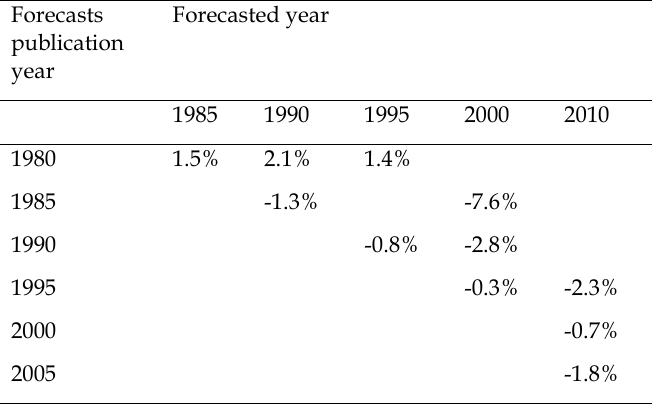
Danish population: resulting percentage differences between forecasted and observed values for 5 years